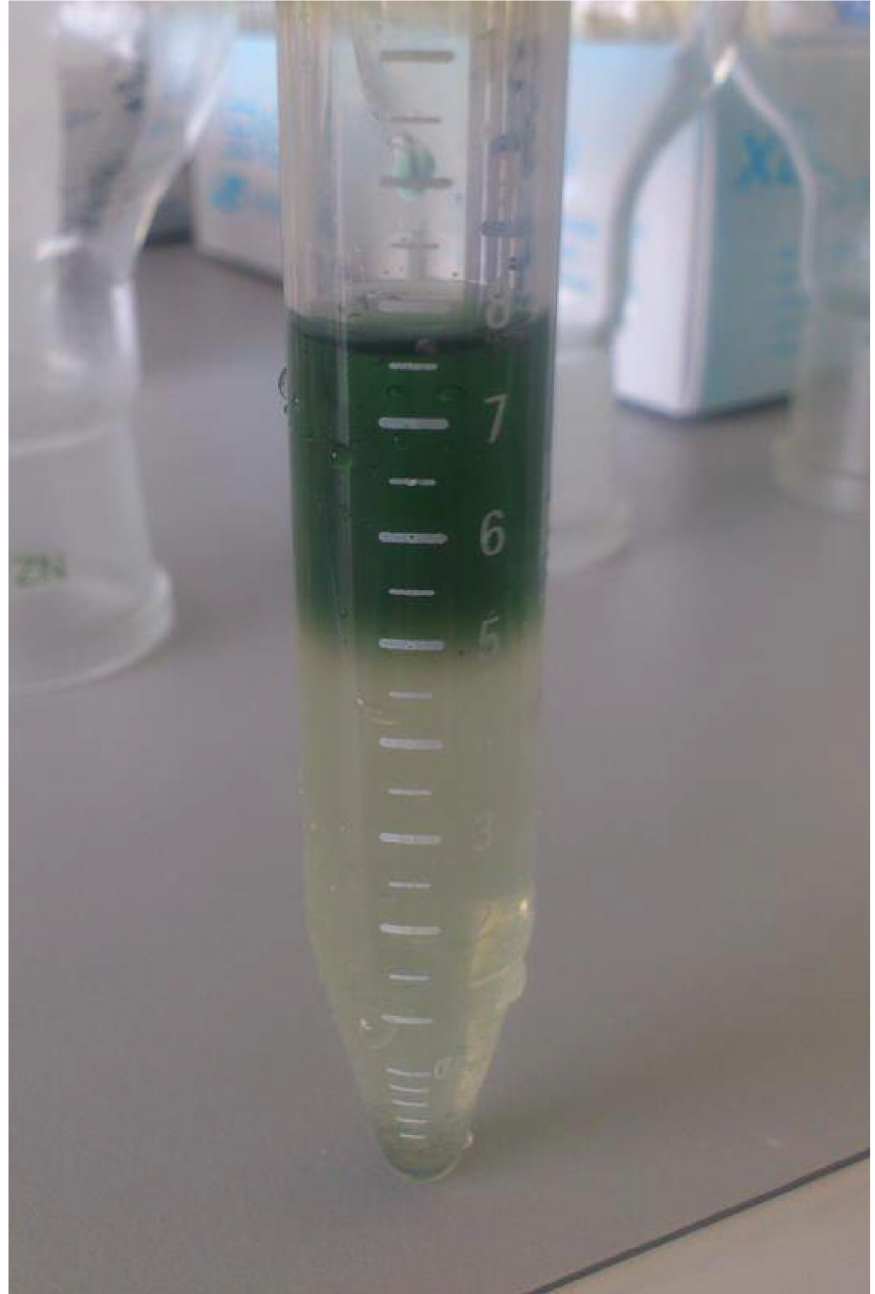
Fig 3. Protein extraction from harvested cyanobacterial cells. This figure shows a photograph of the extract obtained by treating Synechococcus sp.cells (UPOC S4) with ACN/2% (v/v) TFA, 7:3, v/v, after its storage at -20˚C. On freezing, two phases separated. The upper phase was liquid, organic and colored because of the presence of photosynthetic pigments. The bottom phase was solid and almost colorless. It contained a vast majority of the extracted proteins and was further used in protein identification